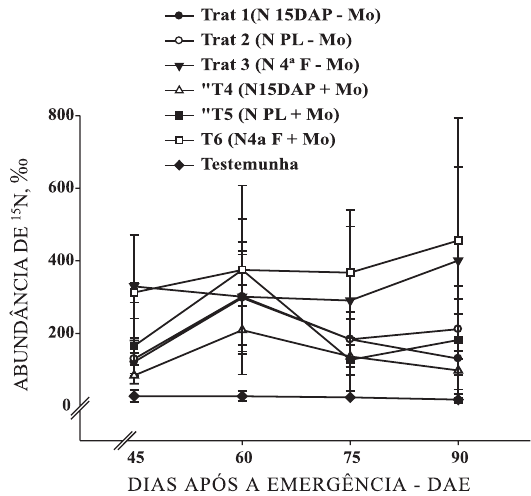
Figura 3. Abundância de N ( 15 N) na folha de milho em função das épocas de aplicação de N na cultura do milho. Barras verticais: intervalo de